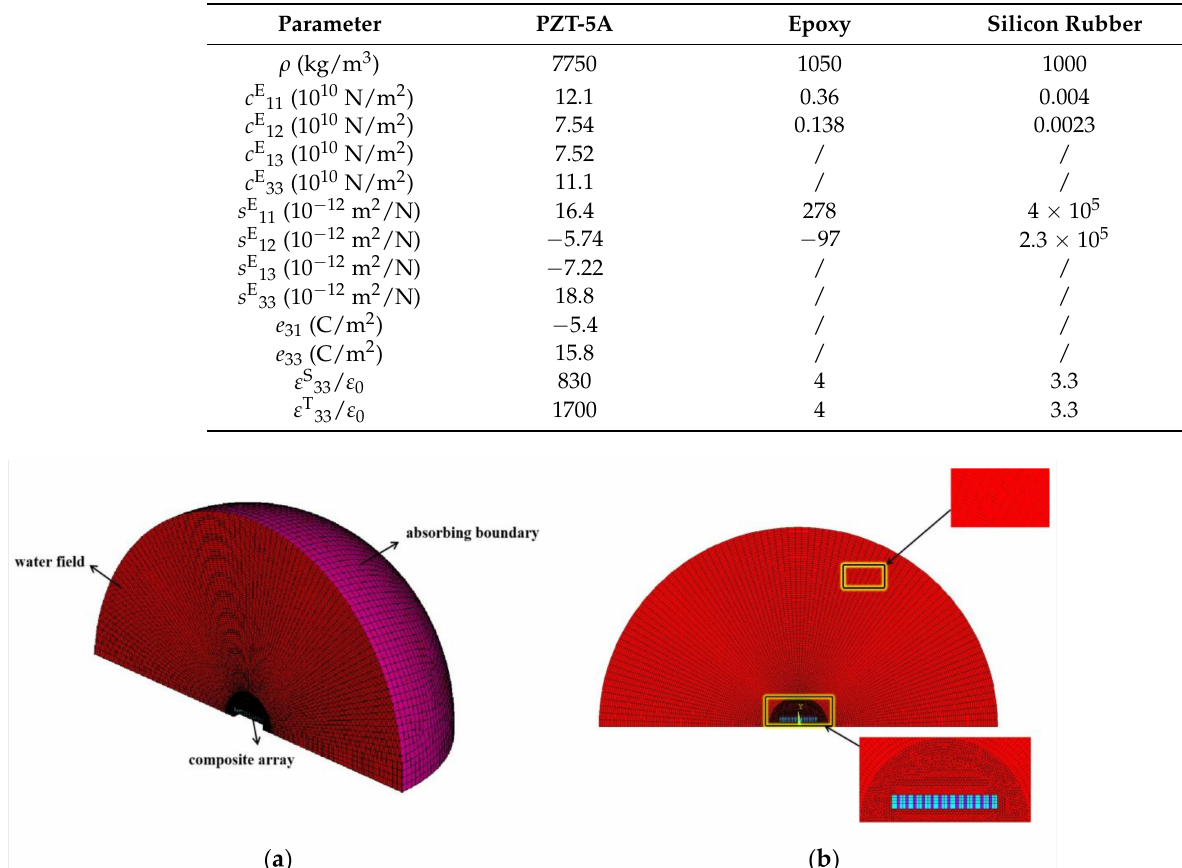
Table 1. Parameters of each component phase in piezoelectric composites.